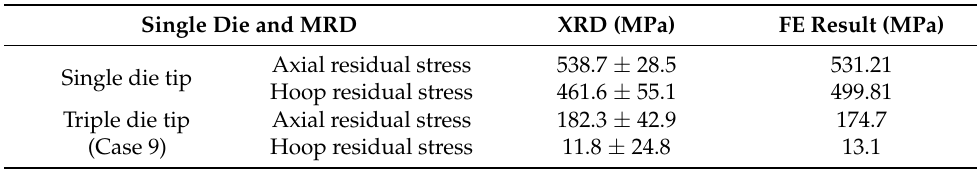
Table 5. Comparison of the measured and predicted residual stresses in the single die and MRD processes.